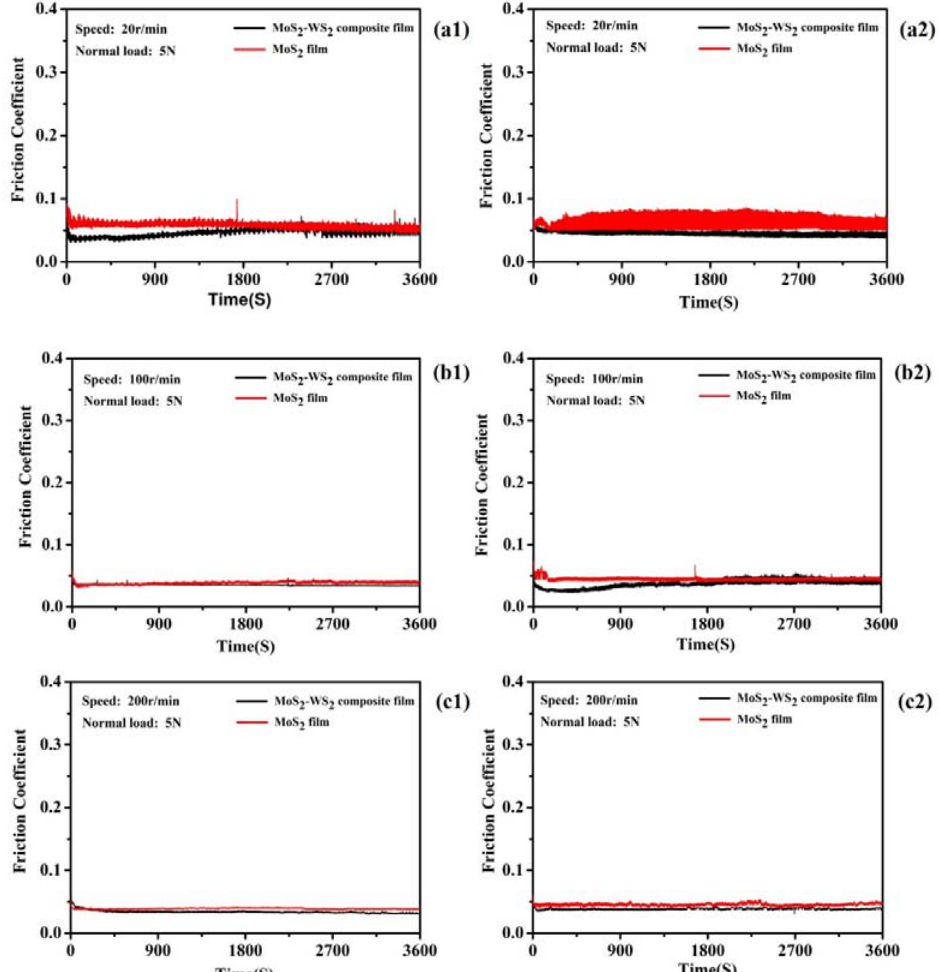
Figure 8. The real-time friction coe ffi cient of pure MoS 2 and MoS 2 –WS 2 composite film before Figure 8. The real ‐ time friction coefficient of pure MoS 2 and MoS 2 –WS 2 composite film before and and after AO-irradiation under vacuum environment. ( a1 , b1 , c1 ): before AO-irradiation; ( a2 , b2 , c2 ): after AO ‐ irradiation under vacuum environment. a1, b1, c1: before AO ‐ irradiation; a2, b2, c2: after after AO ‐ irradiation.